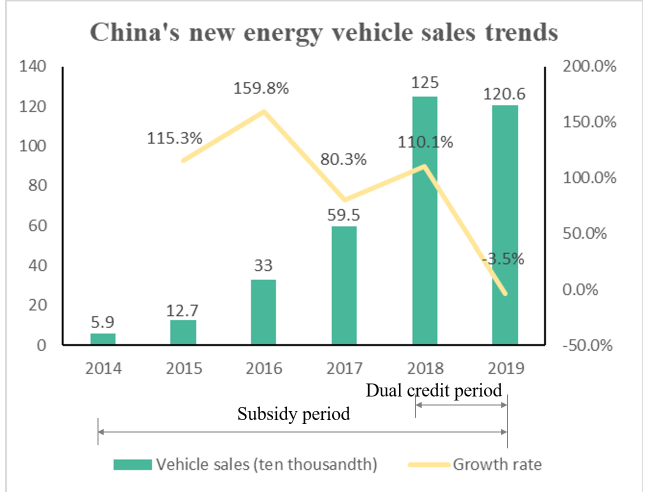
Figure 1. China’s new energy vehicle sales trends. Note: source: China Association of Automobile Manufacturers (http://www.caam.org.cn/english, (accessed on 21 March 2021)).